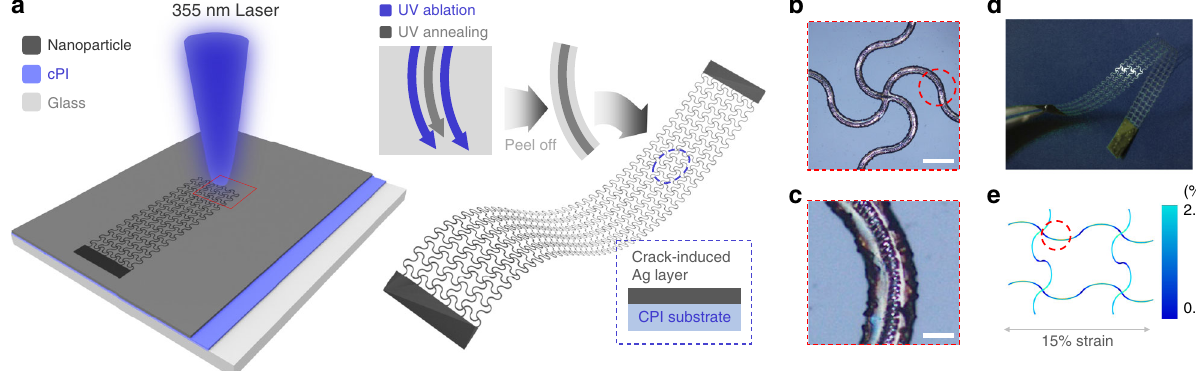
Fig. 2 Highly sensitive skin sensor fabrication by laser-induced crack generation. a Schematic depicting the patterning and crack fabrication by laser fabrication. b Optical image of the fabricated sensor. Scale bar, 200 μ m. c Magni fi ed image of the sensor which distinctively shows the annealed region. Scale bar, 50 μ m. d Picture of the free-standing fabricated sensor. e FEM image showing strain distribution of the